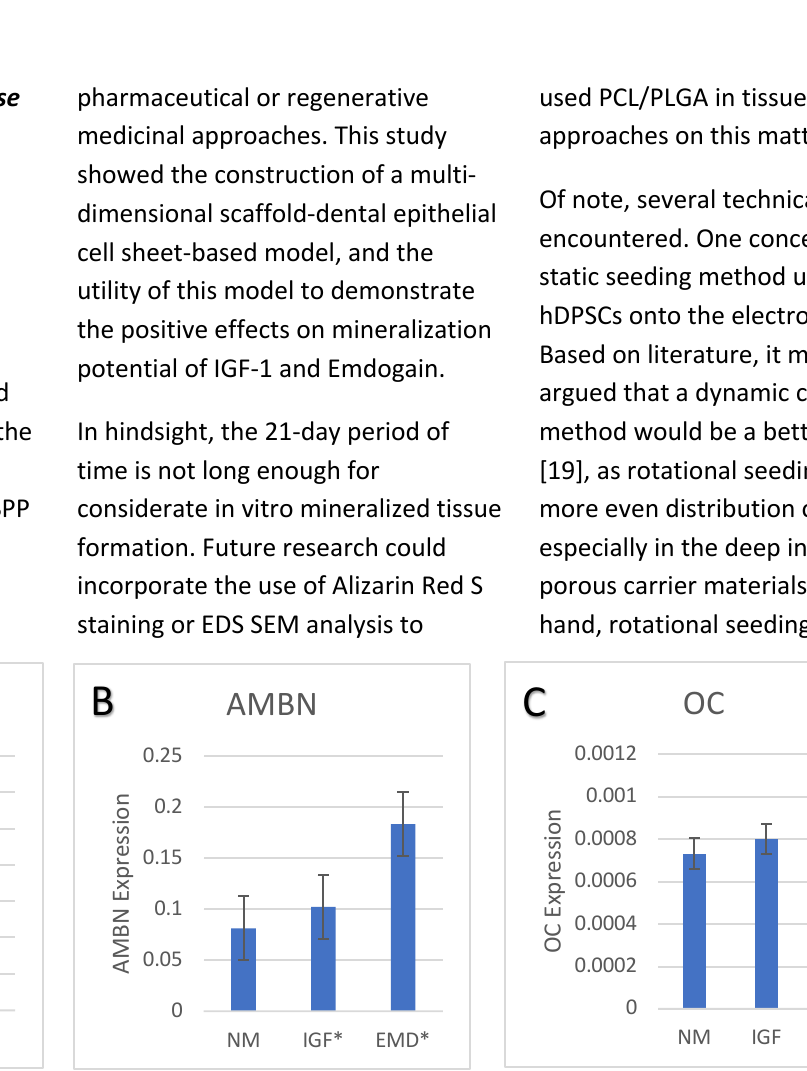
Figure 5. qPCR analyses of dental cell differenKaKon marker expression. Expression of (A) DSPP (B) AMBN(C) BGLAP/OC as normalized to D0 dental cell cultures. The expression of the ameloblast differenWaWon marker AMBN was significantly higher in the IGF-1 and Emdogain treated groups as compared to the NM group (P<0.05). No significant differences in the expression of DSPP and OC were